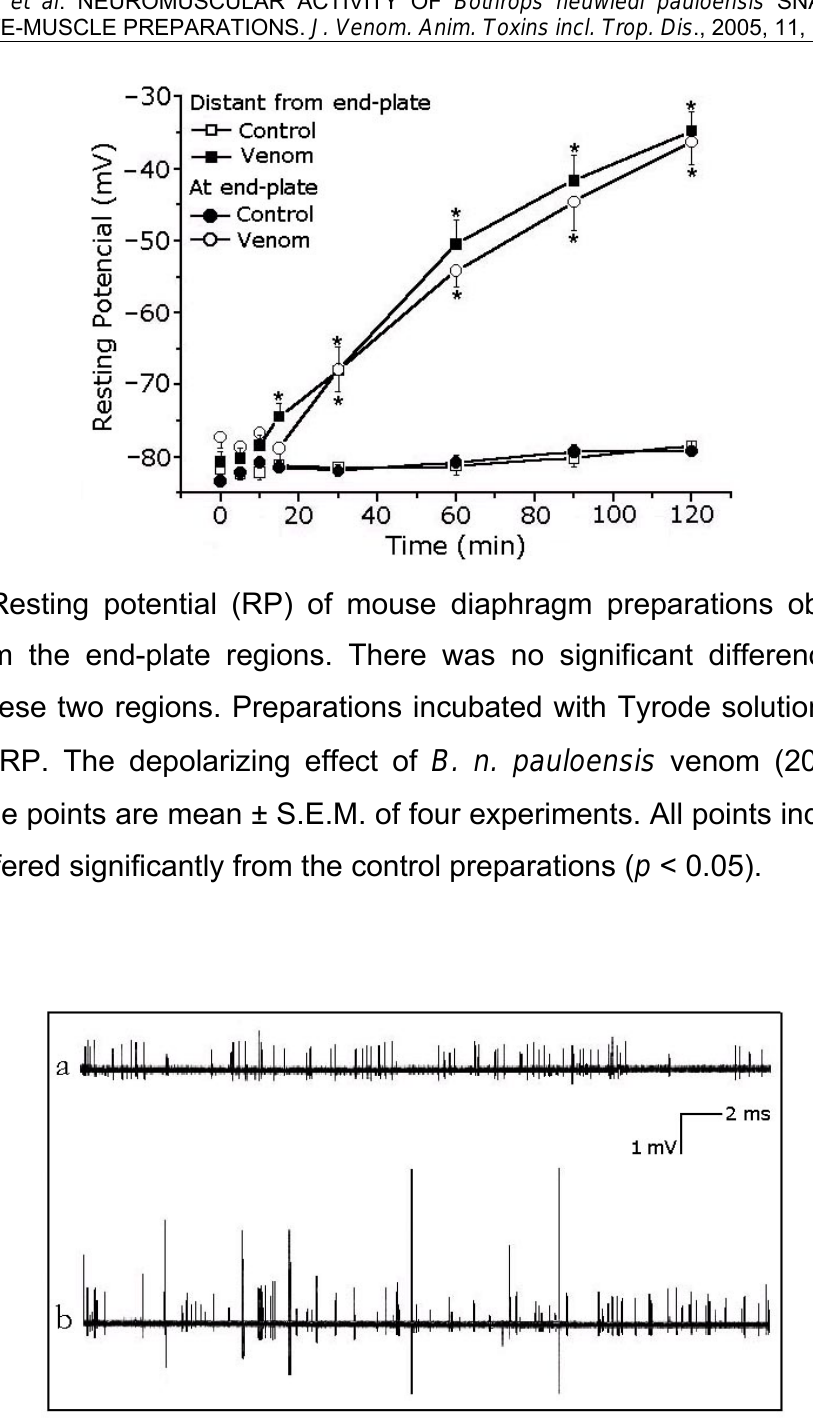
Figure 5. B. n. pauloensis venom (20 µ g/ml) effect on MEPPs amplitude in mouse diaphragm. In (a), preparations exposed to Tyrode solution and, in (b), venom effect. Note in (a) that most MEPPs have amplitudes ≤ 0.9 mV and; in (b), the large potentials (>1.8 mV) appear 30 min after venom addition. These phenomena are indicative of presynaptic events. Recordings are representative of four